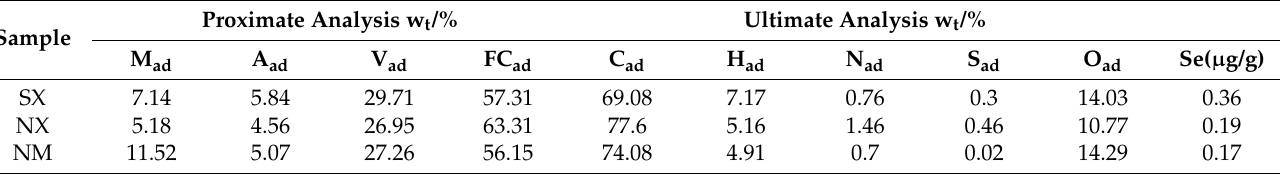
Table 1. The ultimate and proximate analyses of the coal